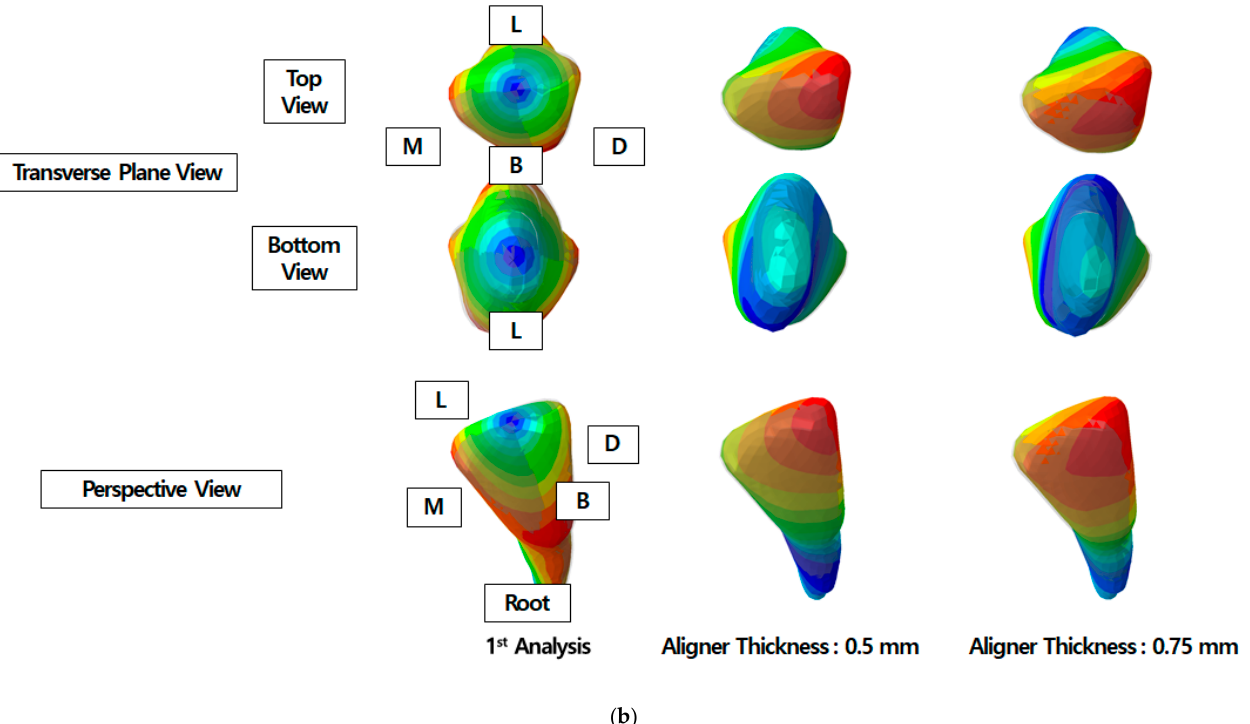
Figure 9. Change in the center of rotation for the central incisor. ( a ) Lingual inclination and ( b ) axial rotation of the central incisor deformation. (L: lingual, B: buccal, M: mesial, and D: distal direction).